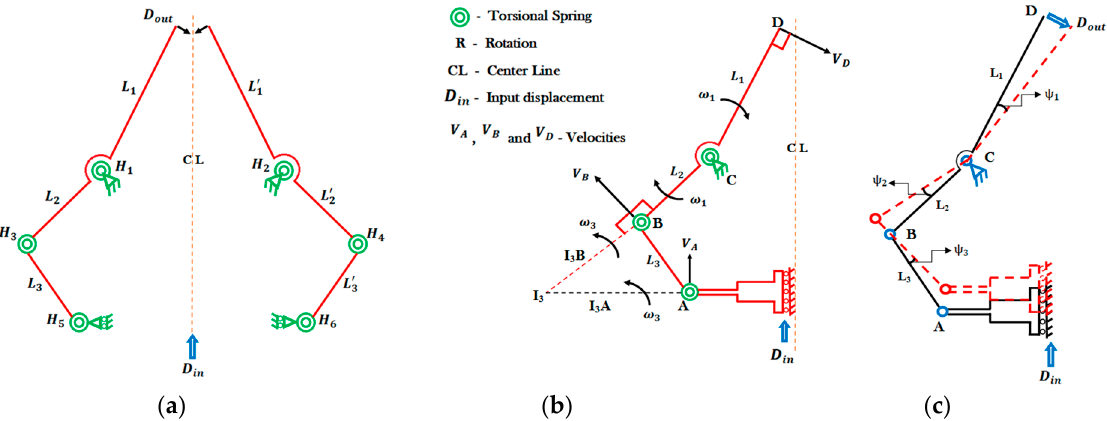
Figure 2. ( a ) Pseudo-rigid-body equivalent model of the microgripper; ( b ) velocity vector diagram of the microgripper; ( c ) angular changes of the microgripper.